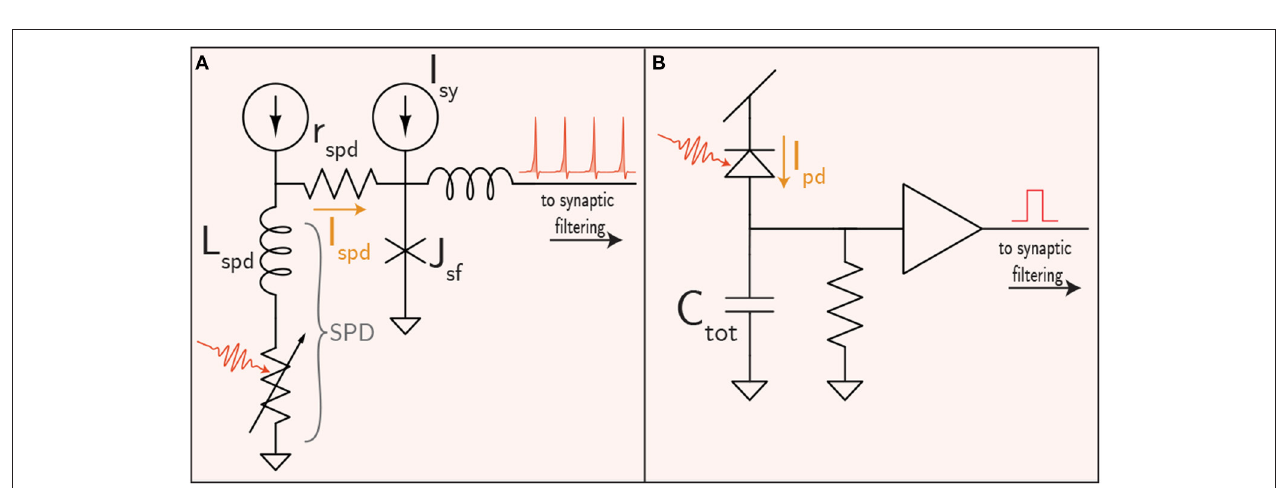
FIGURE 2 | Receivers for the (A) superconducting and (B) semiconducting platforms. Note that synaptic weighting for the semiconductor case is included in the filtering circuitry, shown in Figure 4B .